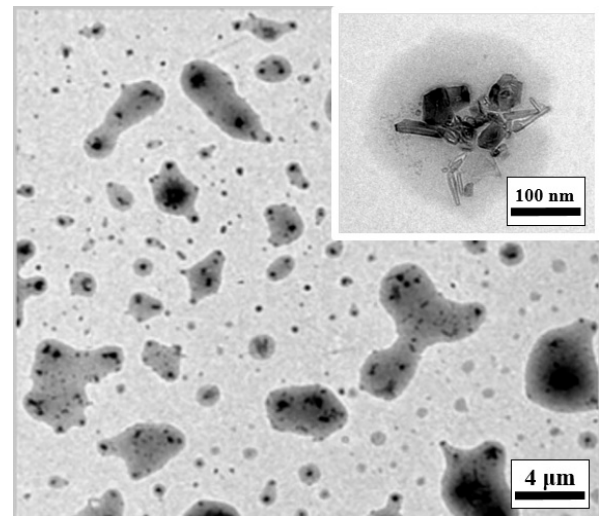
Figure 2. TEM images of CNCs dispersed in emulsified oil.